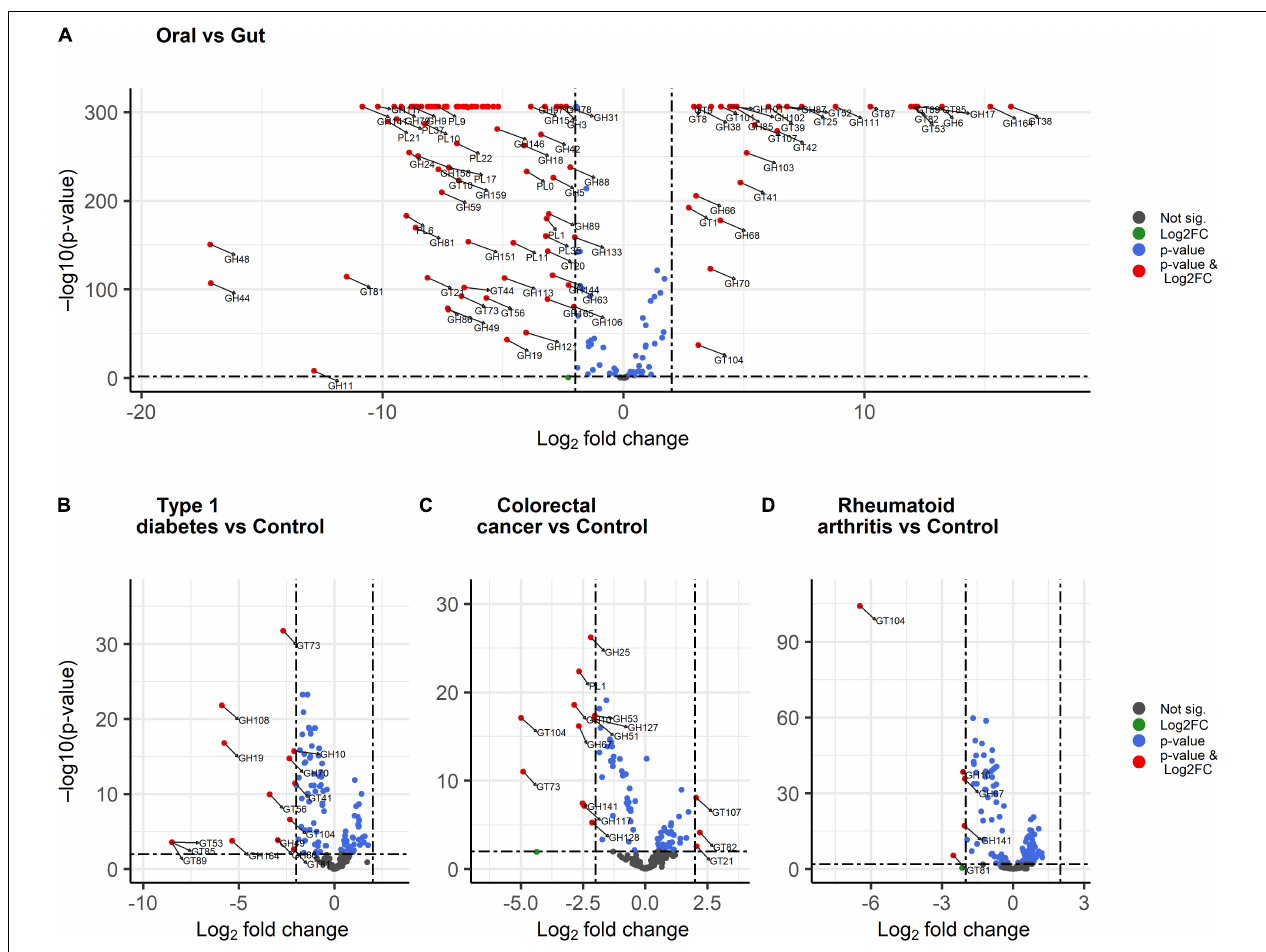
FIGURE 7 | Volcano plots showing differentially abundant CAZymes between body sites and disease conditions. (A) oral versus gut, (B) colorectal cancer versus control, (C) type 1 diabetes versus control, and (D) rheumatoid arthritis versus control. The red dots display CAZyme families with both large log2 fold change > 2 or < –2 and a high statistical significance (–log10 of p -value, y -axis). The blue dots are CAZyme families with points above the horizontal line having p < 0.01, the gray dots represent CAZymes having p > 0.01 while the green dots are CAZymes with large log2 fold change > 2 or < –2 and p > 0.01 and below the horizontal